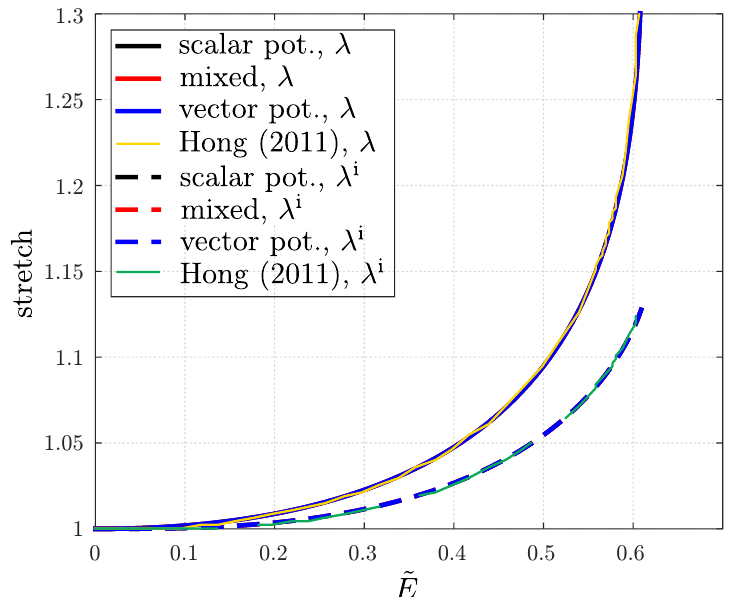
Figure A1. Comparison between the present formulation and the results obtained by Hong